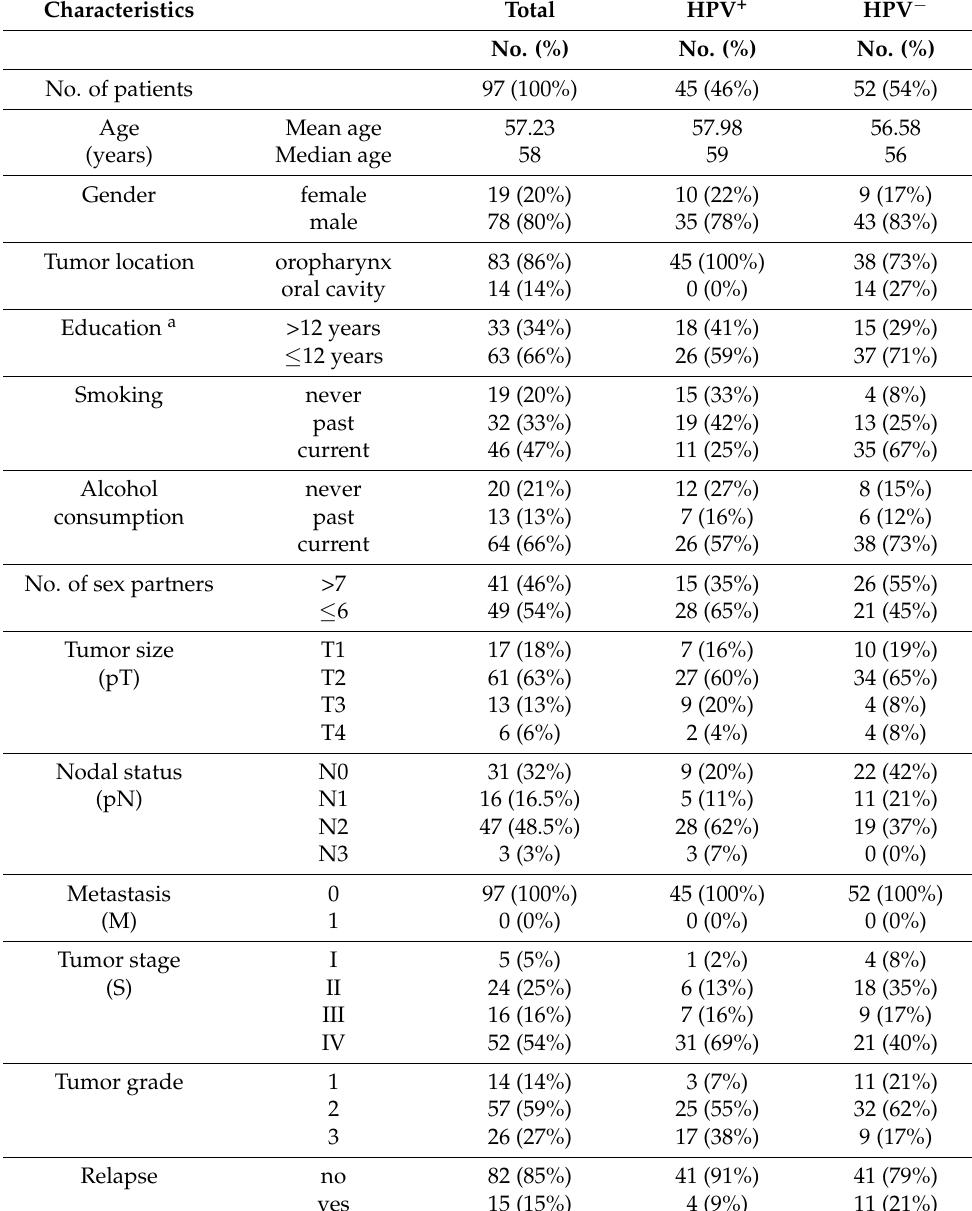
Table 3. Patient demographics and clinical